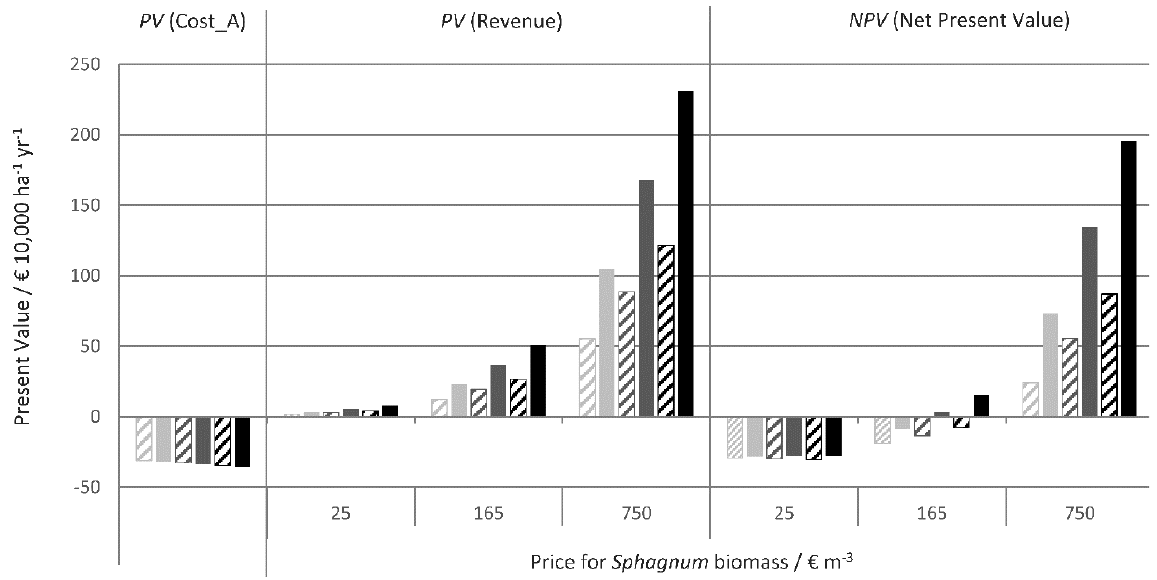
Figure 7. Present Values ( PV ) of Sphagnum farming for high costs (Scenario A) and Revenues and the resulting Net Present Values ( NPV ) according to price level (€ 25, € 165 or € 750), average dry mass yield (light grey: 2.0; dark grey: 3.2; black: 4.4 t ha -1 yr -1 ) and the conversion factor for bulk density (solid fill: 20 g L -1 ; hatched fill: 38 g L -1 ).